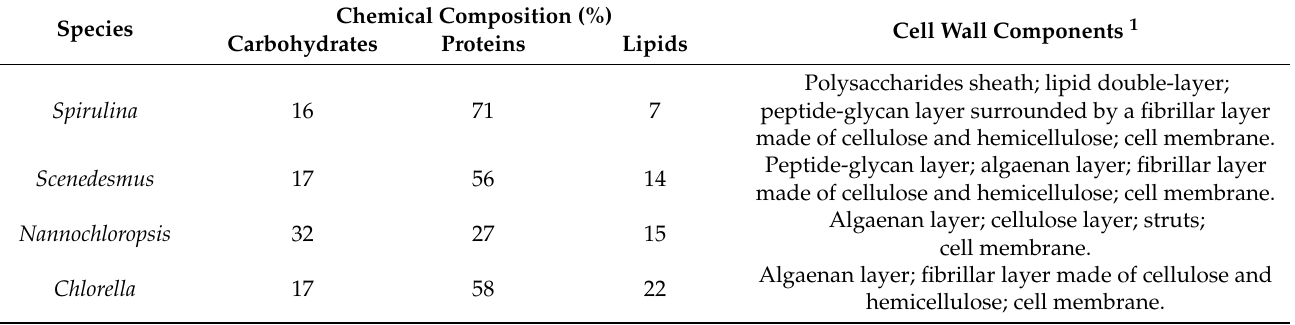
Table 1. Approximate chemical composition and cell wall components of biotechnologically relevant